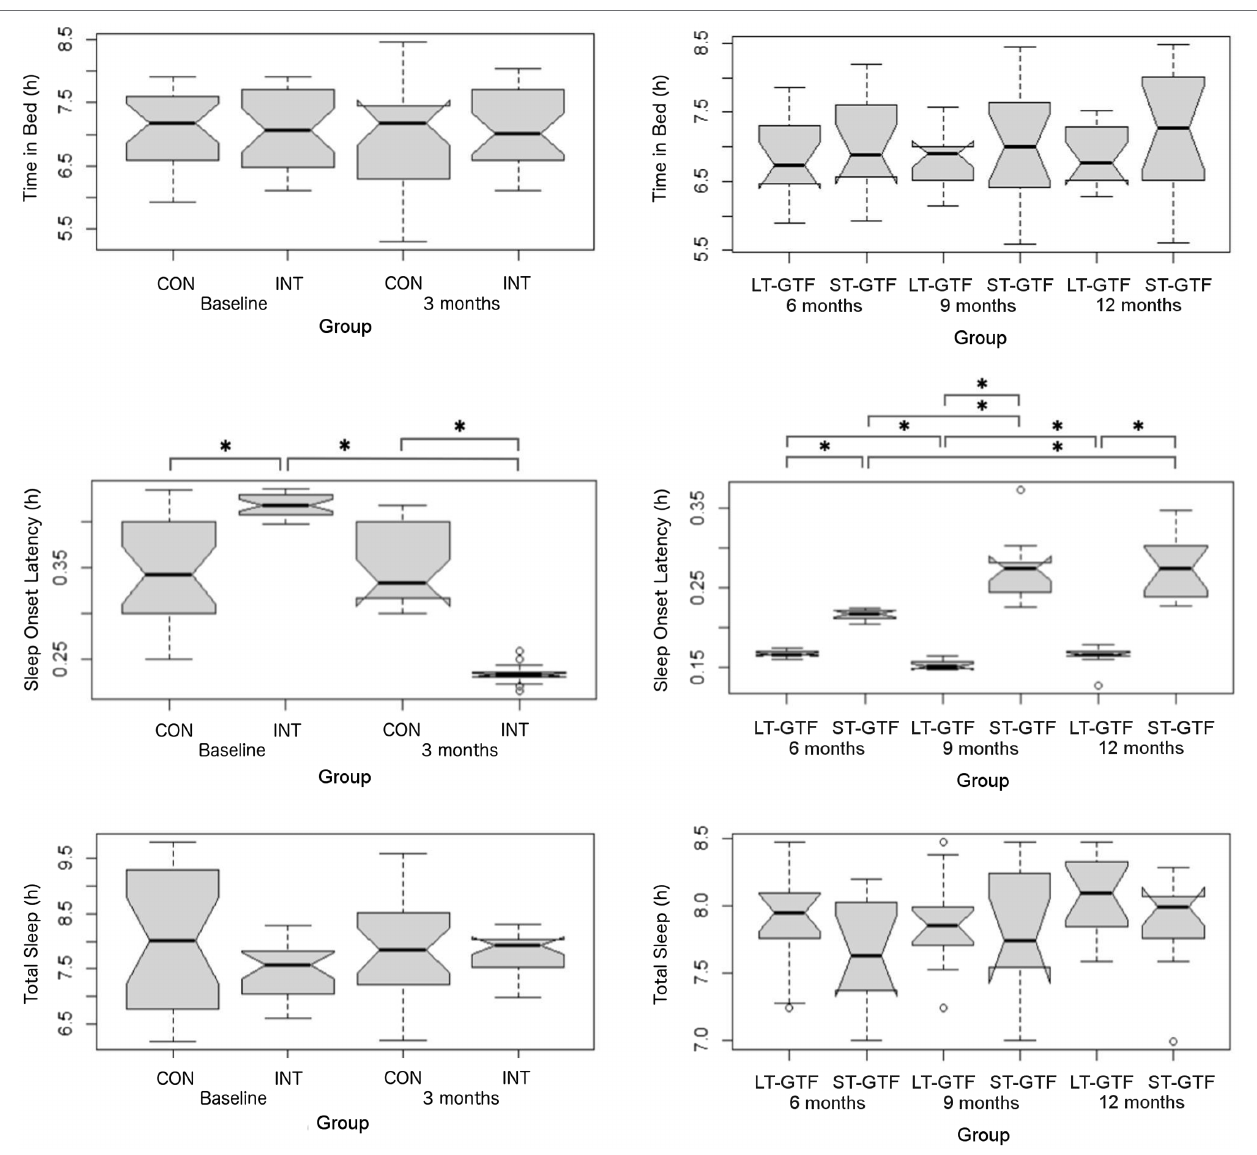
FIGURE 4 | Sleep metrics (Time in Bed, Sleep Onset Latency, and Total Sleep). Graphs on the left represent control (CON) and intervention (INT) groups from baseline to month 3. Graphs on the right represent measurements taken at 6, 9, and 12 months. LT-GTF, Long-term GTF group; ST-GTF, Short-term GTF. * Represent statistically significant